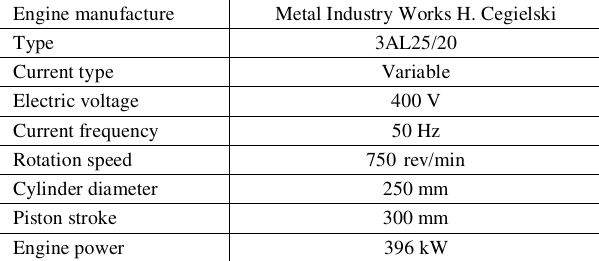
Table 1. Characteristics of the SULZER 3AL25/30 engine